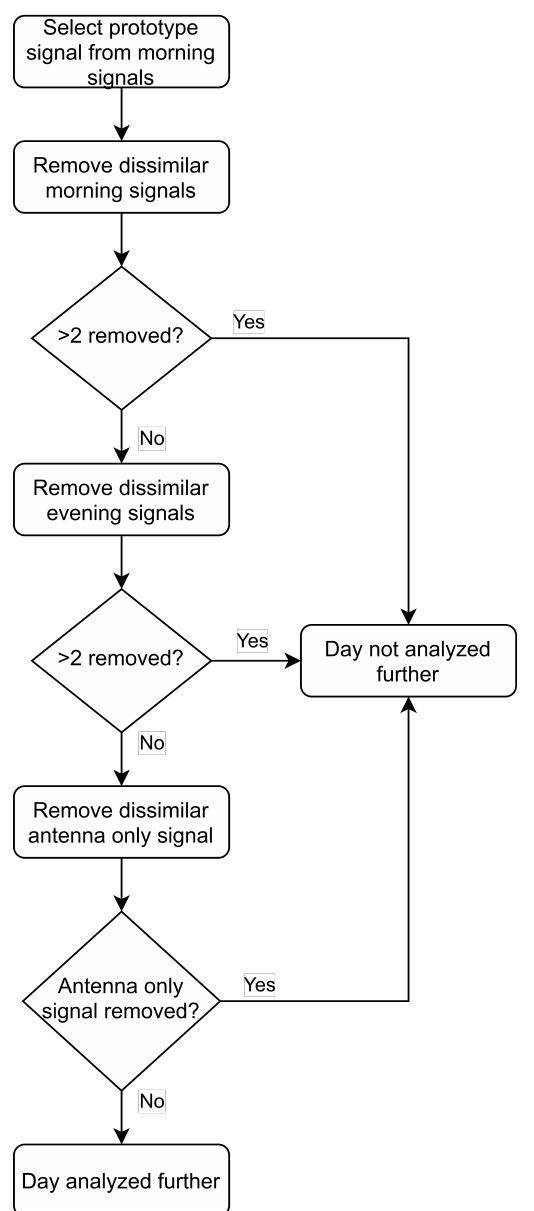
Figure 9. Algorithm for comparing connection quality between measurements and omitting mea-